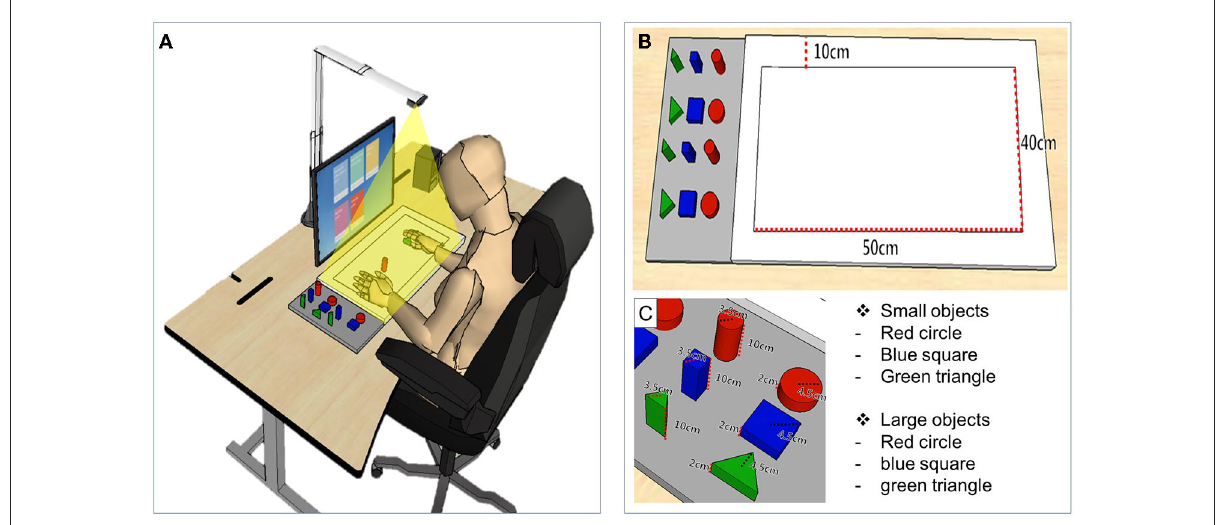
FIGURE1 The simulation of training and description of detailed devices in mixed reality (MR)-board. (A) Schematic illustration of training using the MR-board. The camera on the MR-board displayed all movements of the hands and objects on the board on the monitor. (B) Specifications of the MR-board. The thickness of the board was 10cm and the actual training space was 500mm (length) × 400mm (width). (C) The objects consisted of two sets of six shapes and